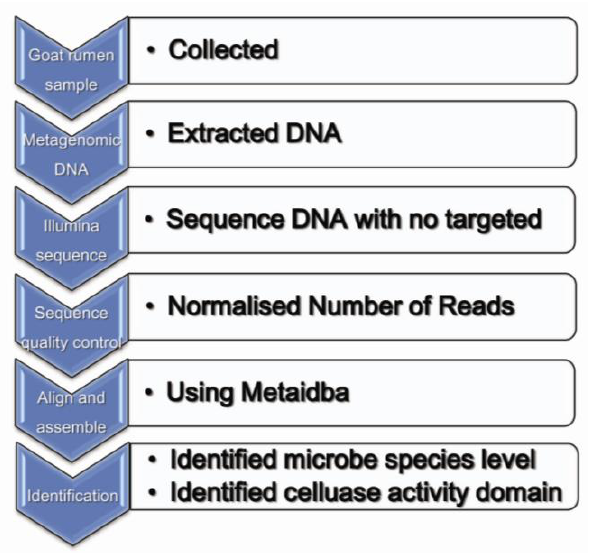
Supplementary Figure 1. Each pair read, scaffold and contig from the shotgun sequencing of goat rumen